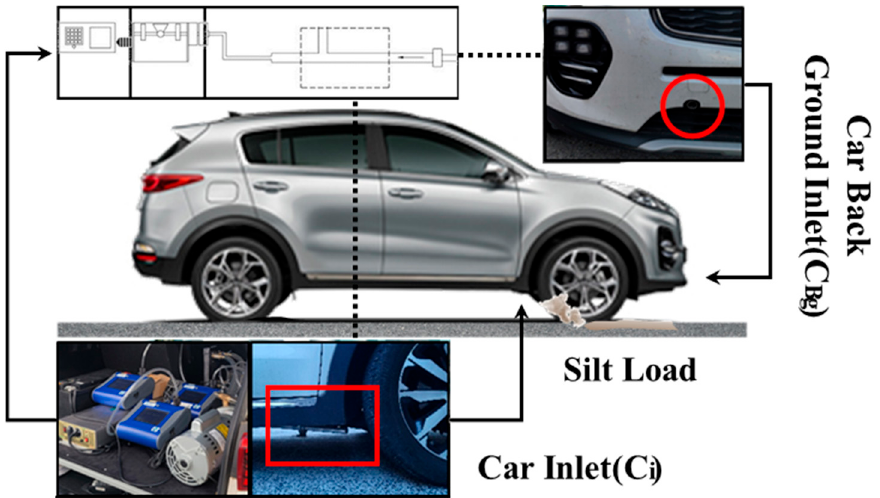
Figure 2. Configuration of the resuspended PM 10 measurement system.